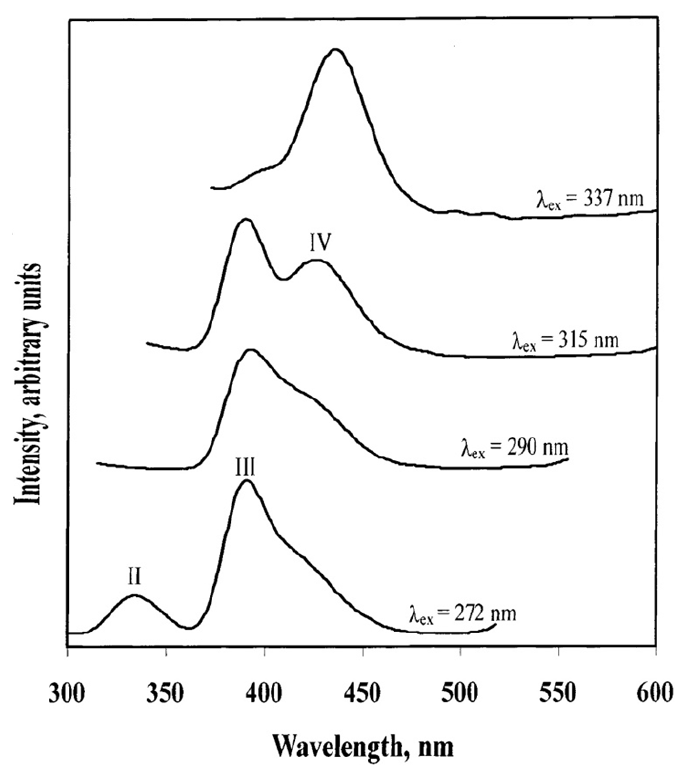
Figure 6. Emission spectra of a single crystal of KAu(CN) excitation wavelengths. (Reprinted with permission from [38]. Copyright 2002 American Chemical